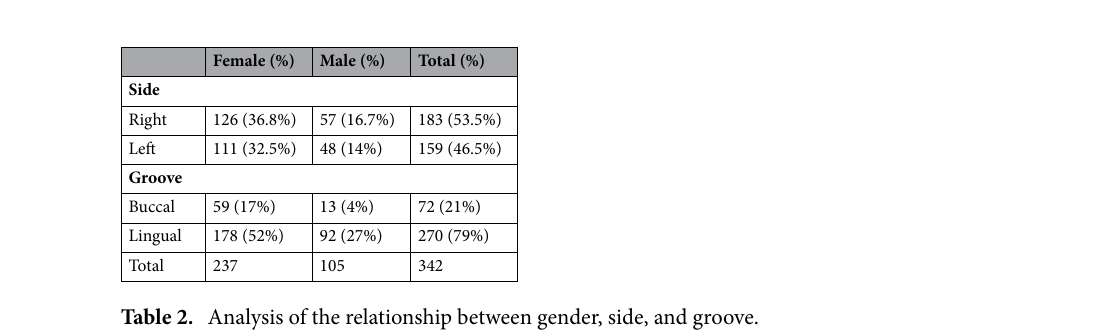
Table 2. Analysis of the relationship between gender, side, and groove.